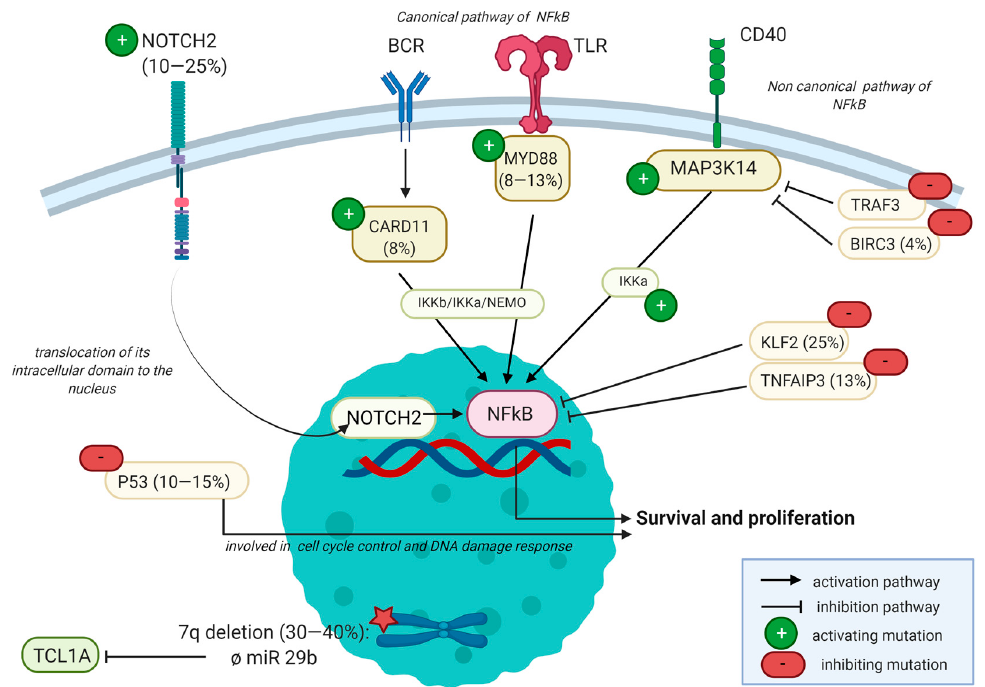
Figure 3. Summary of lymphomagenesis of SMZL created using BioRender.com thanks to these two reviews [48,50]. The mutation of NOTCH2 (arising in 10–25% of SMZLs) will lead to the translocation of its intracellular domain to the nucleus, inducing a constitutive activation of this pathway and resulting in the transcription of multiple genes. It is associated with mutations that will have the effect of activating the NF κ B pathway, such as CARD11 (among 8% of cases) or MYD88 via Toll-like receptors (TLRs). The canonical pathway for the NF κ B activation also passes through IKKb (itself mutated in 4% SMZL). Other mutations impact the MAP3K14 pathway, involving TRAF3 and BIRC3 (mutated in 4% of SMZLs) complexes, leading to the activation of NF κ B via its non-canonical pathway, passing through IKKa . Other mutations are inhibitory, such as the KLF2 (25%) or TNFAIP3 (13%) mutations. Apart from mutations, these two molecules play a role in inhibiting the NF κ B pathway. Created with BioRender.com, accessed on 6 September 2021. Abbreviations: BIRC3 , baculoviral IAP repeat-containing protein 3; BCR , B-cell receptor; CARD11 , caspase recruitment domain-containing family member 11; CD40 , cluster of differentiation 40; IGVH: immunoglobulin G heavy chain; IKKa/b , inhibitor of nuclear factor kappa B kinase subunit alpha/beta; KLF2 , Krüppel-like factor 2; MAPK , mitogen-activated protein kinase; MYD88 , myeloid differentiation primary response 88; NEMO , NF-kappa-B essential modulator; NF κ B, nuclear factor kappa B; NOTCH , neurogenic locus notch homolog protein; TCL1A , T cell leukemia family AKT coactivator A; TLR, Toll-like receptor; TME, tumor microenvironment; TNFAIP3 , tumor necrosis factor alpha-induced protein 3; TP53 , tumor protein P53; TRAF3 , tumor necrosis factor receptor-associated factor